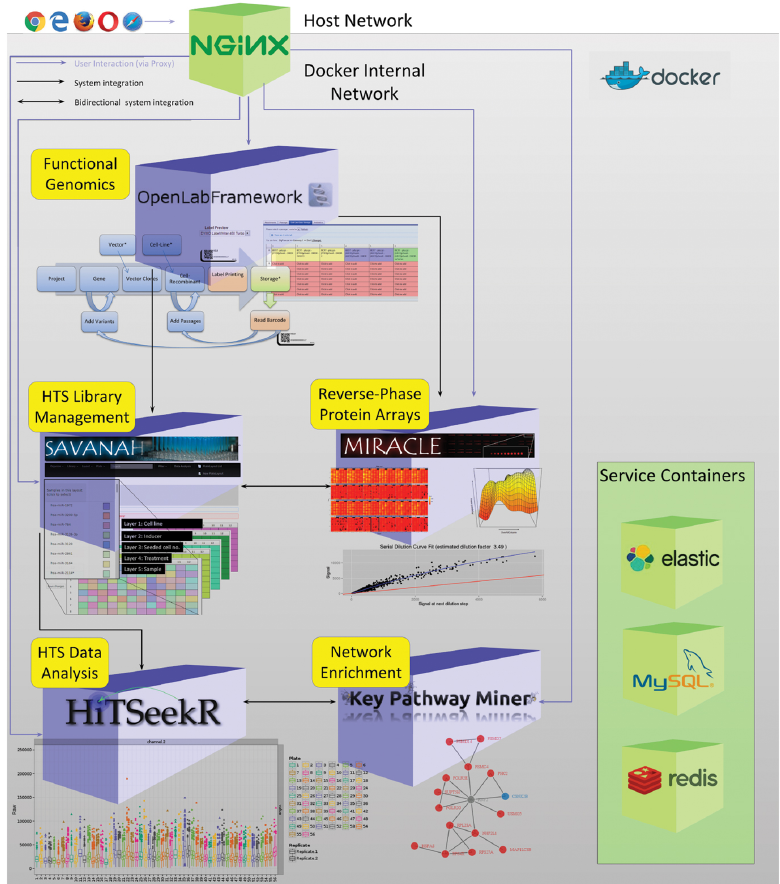
Figure 2: Overview of the high-throughput screening platform with individual Docker containers for each application (purple boxes). Pre-defined network connections facilitate protected internal communication among the tools where needed (black arrows). Service containers (green boxes) are shared by all applications (black arrows omitted here for clar- ity). An NGINX Docker container serves as the single entry point to the platform and enables user access to individual tools through the web browser (purple